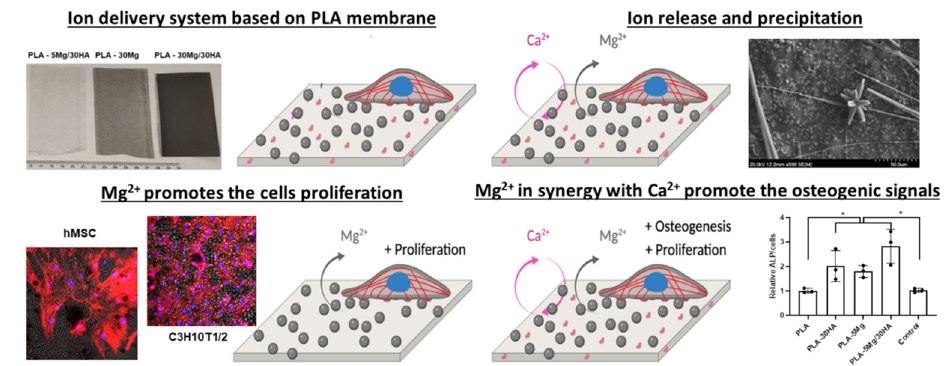
Figure 9. Summary figure of proposed approach. Tape casted methods used with PLA allow the formation of membranes potentially useful for Guided Bone Regeneration purposes. The method allows the loading of bioactive particles at PLA by colloidal suspension. This loading affects some parameters at material surface but did not affect materials biocompatibility. At in vitro cell culture studies, Mg loaded PLA membranes show improved cell proliferation, while Mg and Ca loaded PLA membranes show improved osteoinduction and proliferation, suggesting synergic effects taking place.